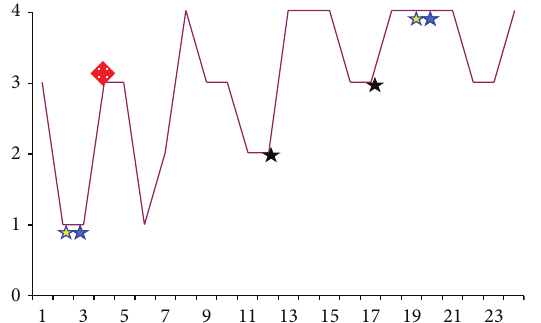
Figure 7: Revision surgeries after radiological evaluation without decoupling. Stars with the same colour indicate revised cases before and after the revision. The red diamond indicates a case which was revised but had no scan available from after the first surgery (retrospective case). AF values in dB.